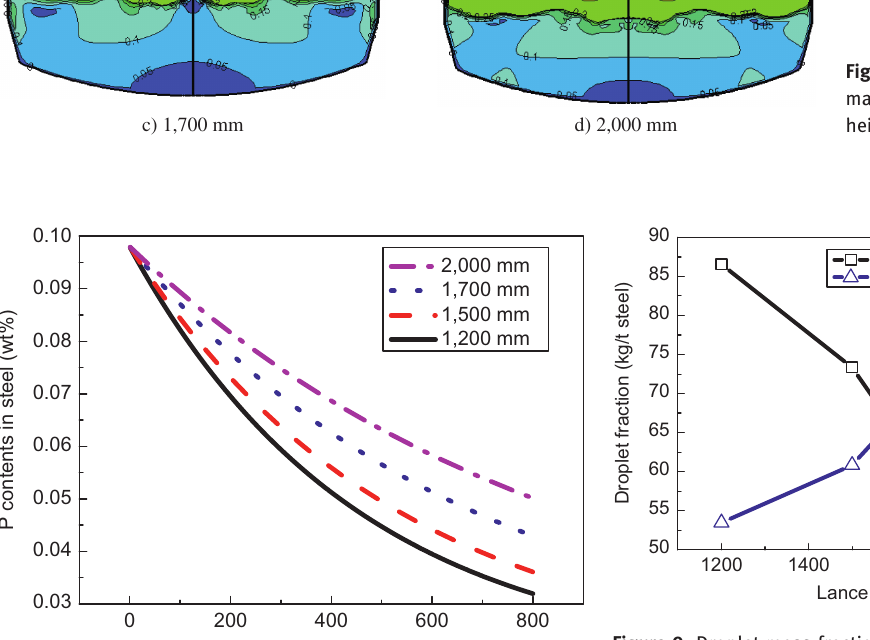
Figure 9: Droplet mass fraction vs end phosphorus content at dif- ferent lance